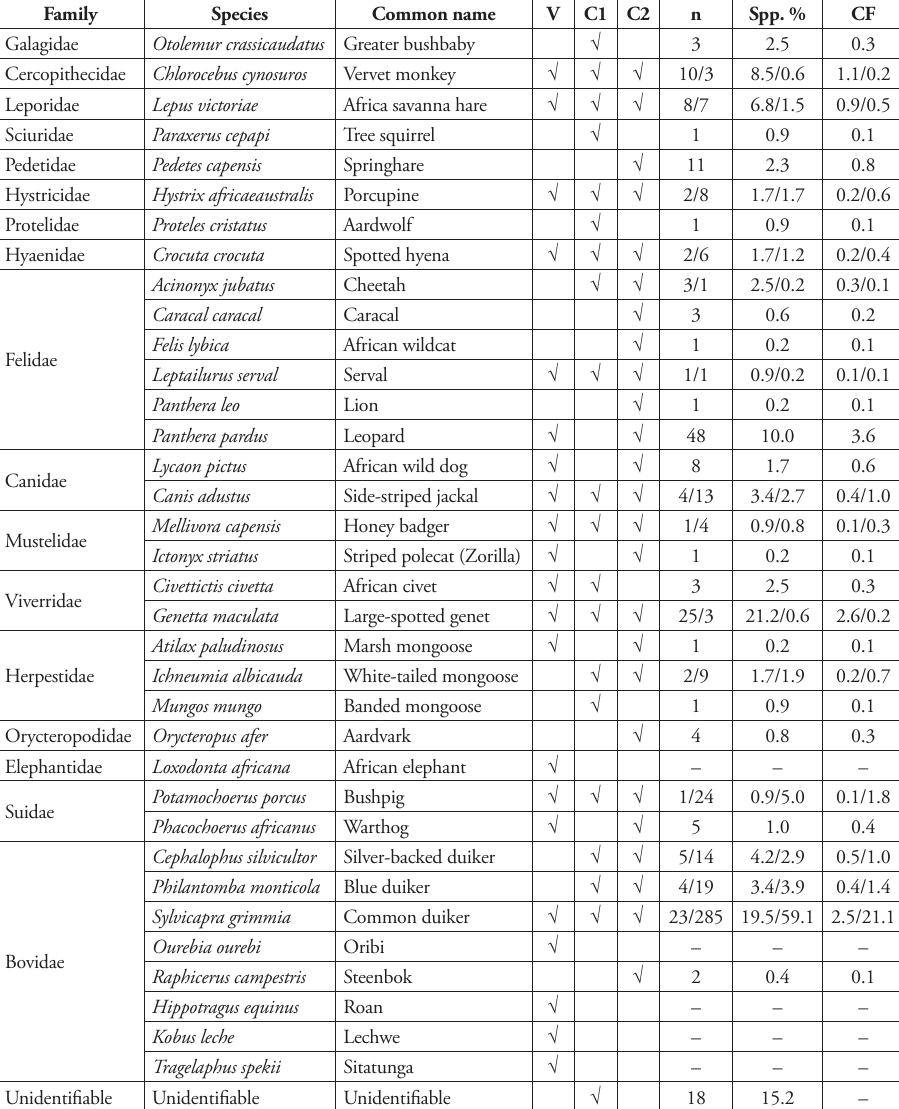
Table 3. All medium-large mammal species detected opportunistically (see methods) and during two formal camera-trapping surveys of the south-eastern highlands of Angola in 2016. Where applicable, the total number of photographic events per species (n), their percentage contribution (Spp. %) to the total number of photographic events, and the capture frequency (CF) (number of events/100 camera days) is shown. V = verified opportunistic sighting, C1 = camera trap survey 1, C2 = camera trap survey 2. If a species was recorded in both camera-trapping surveys, the values for both surveys are separated by a backslash (i.e.,